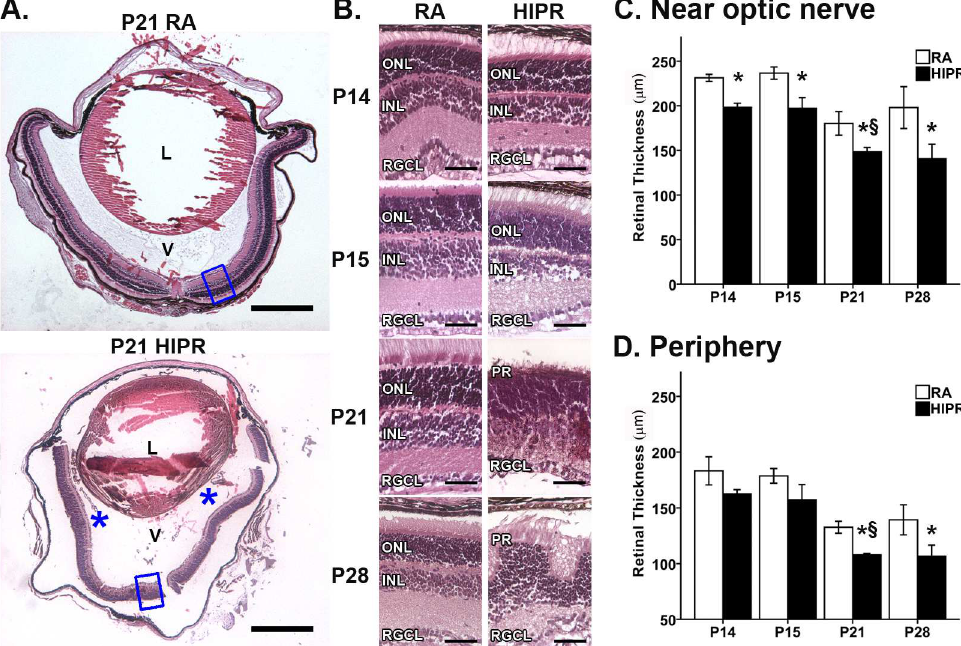
Fig 6. Retinal thinning near the optic nerve and in the peripheral retina in hyperoxia-induced proliferative retinopathy. (A) Cross sections of P21 RA (top) and HIPR (bottom) showingpersistent hyaloidal vessels (blue asterisk). Insets (blue rectangles) correspond to highermagnification images in (B). Scale bar, 500 μ m. L, lens. V, vitreous. (B) Cross sections were H&E stained(N = 3–4). In HIPR at P21 and P28, the outer nuclear layer and inner nuclearwere not distinguishable, indicating severe thinningof the outer plexiformlayer. Scale bar, 50 μ M. ONL, outer nuclear layer. INL, inner nuclearlayer. RGCL, retinal ganglioncell layer. PR, photoreceptors. The thickness of retinal layers at 100 μ m from the optic nerve (C) or in the retinal periphery(D). (C) Near the optic nerve, HIPR had thinner retinas at all time points comparedto RA. (D) At P15, P21, and P28, the peripheral HIPR retinas were significantly thinner than RA. * p < 0.05 HIPR to respectiveage-matched, RA. § p < 0.05HIPR P21 compared to HIPR P15. Values were mean ± SEM (N = 3–4).